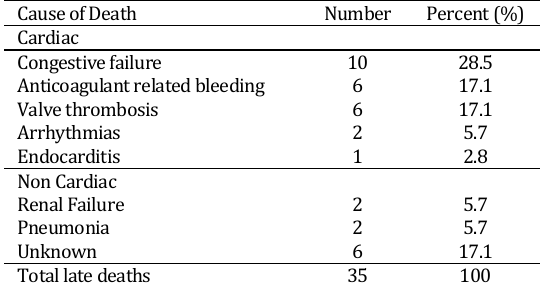
Table 3. Causes of late death after double valve replacement Cause of Death